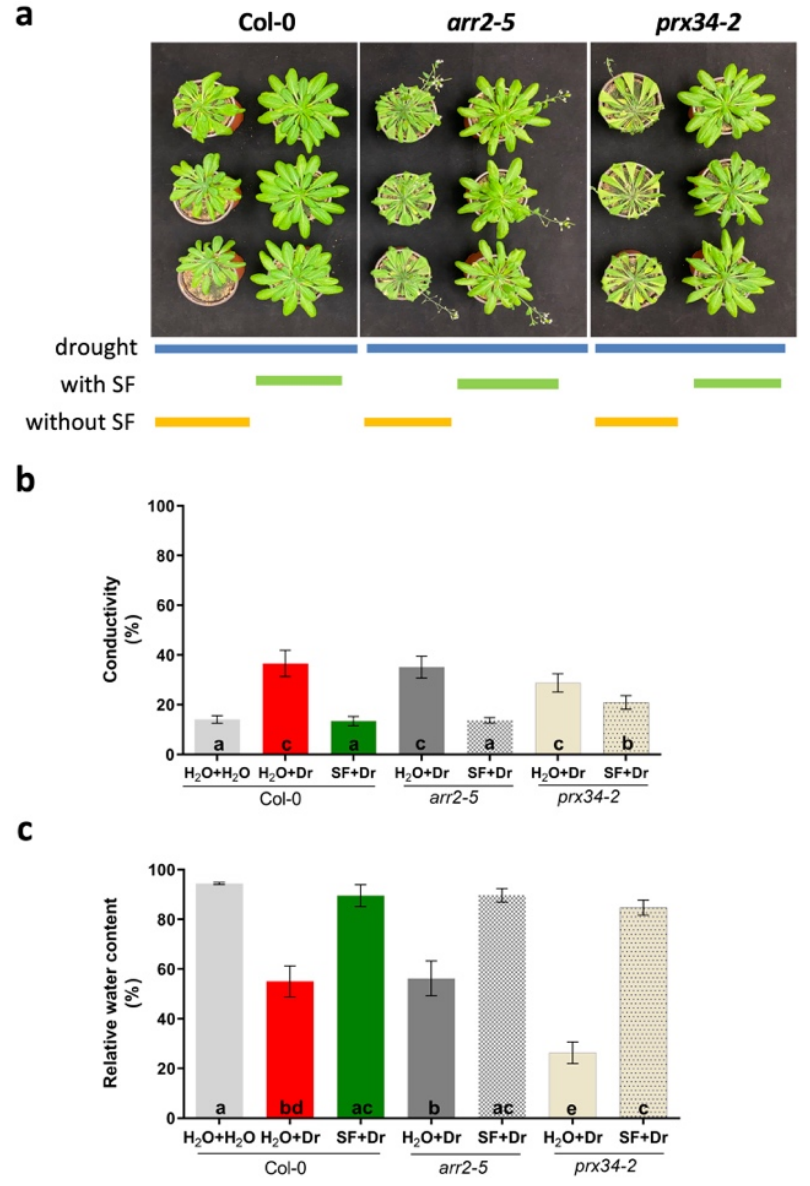
Figure 7. Response to drought in arr2-5 and prx34-2 mutants. ( a ) Response of plants exposed to 11 days of drought. ( b ) Ion conductivity as a measure of membrane damage. ( c ) Relative water content. Data are shown for wild type (Col-0), arr2-5 and prx34-2 plants (leaves 10 and 11). Treatments sharing different letters represent statistically significant differences from each other ( p < 0.05; one- way ANOVA, Tukey’s multiple comparisons test). Dr, drought stress; SF, Super Fifty.